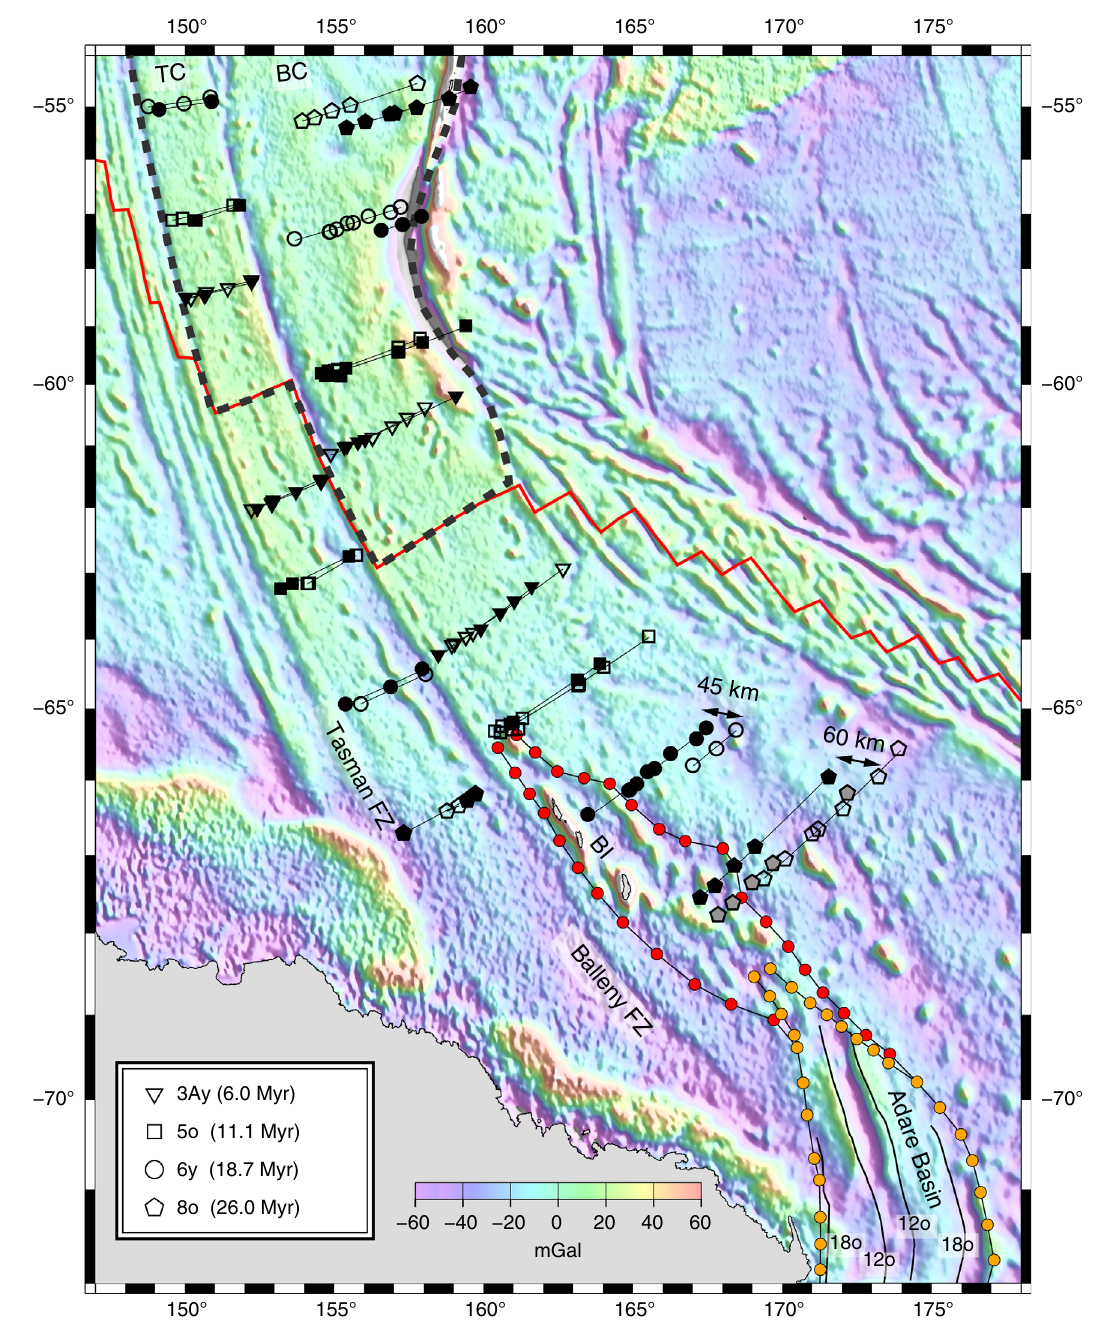
Fig. 2 Magnetic anomaly locations in the Balleny and Tasman corridors. Background is the satellite-derived free-air gravity fi eld 53 . The positions of the anomalies (open symbols) are compared to those from the conjugate plate ( fi lled symbols), rotated using the Australia-East Antarctica rotations 30 . Anomalies from the Macquarie microplate, delineated by a dashed line, are corrected for Macquarie-Australia motion (Table 1). Rotated anomalies 6y and 8o from the Balleny corridor mis fi t the positions of their Antarctic counterparts by 45 and 60 km, respectively. Grey-shaded anomaly picks (8o locations) are rotated using the Macquarie-Australia-West Antarctica rotation (Table 1). Dotted red lines delineate the region of crust affected by Neogene East- West Antarctic motion. Dotted orange lines con fi ne the Adare Basin with its internal anomalies 12o and 18o. BI, Balleny Islands; TC, Tasman corridor; BC, Balleny